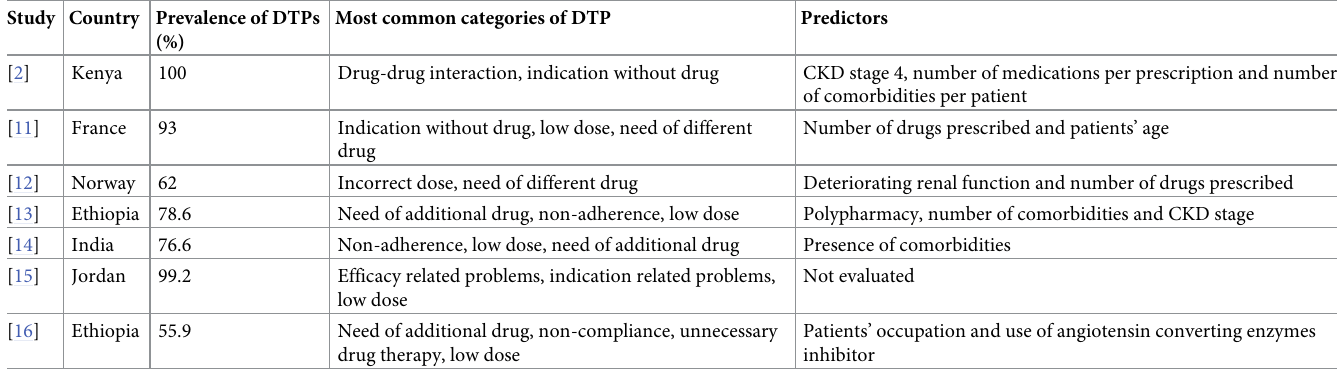
Table 1. Prevalence, categories and predictors of DTPs among CKD